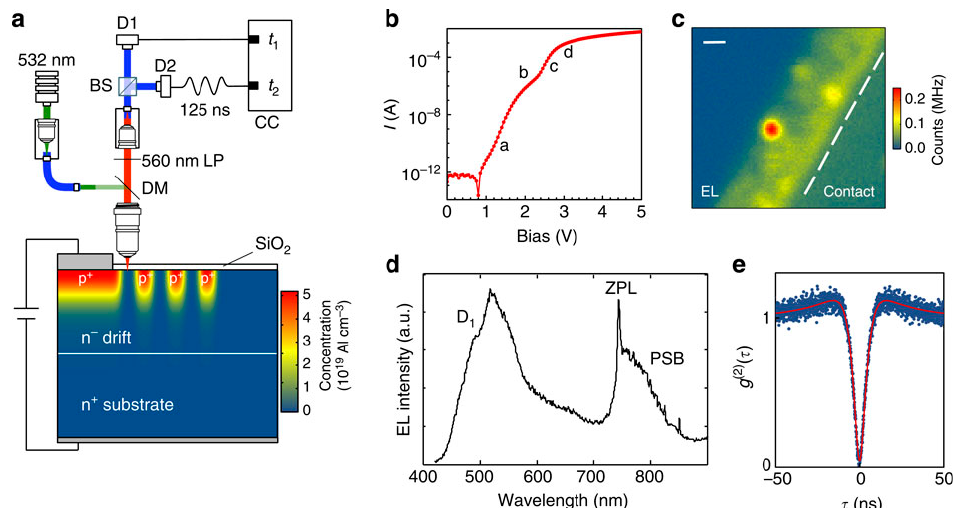
Figure 2. ( a ) Schematic of the confocal setup used to characterize the single-photon emitters; ( b ) Current-Voltage curve of the diode; ( c ) electroluminescence (EL) map of the edge region of a device; ( d ) room temperature EL spectrum; ( e ) background corrected anti-bunching traces with g (2 )( τ = 0) < 0.1. Reprinted by permission from Reference [21], copyright 2015, Macmillan Publishers Ltd.: Nature Communications.